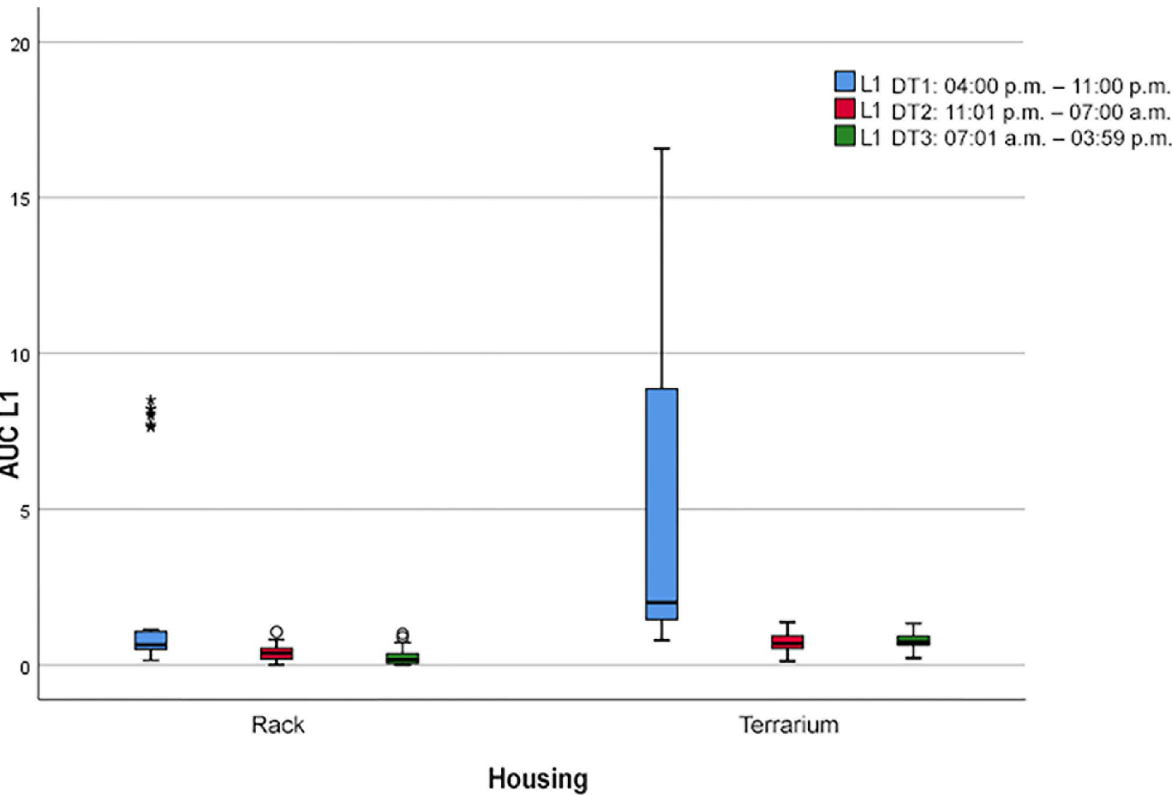
Fig 5. Boxplot with extreme outliers ( � ). Frequency of the locomotion behavior “crawling forward” (L1) during the three daytime periods (P) depending on the two housing systems ( p < 0.05).